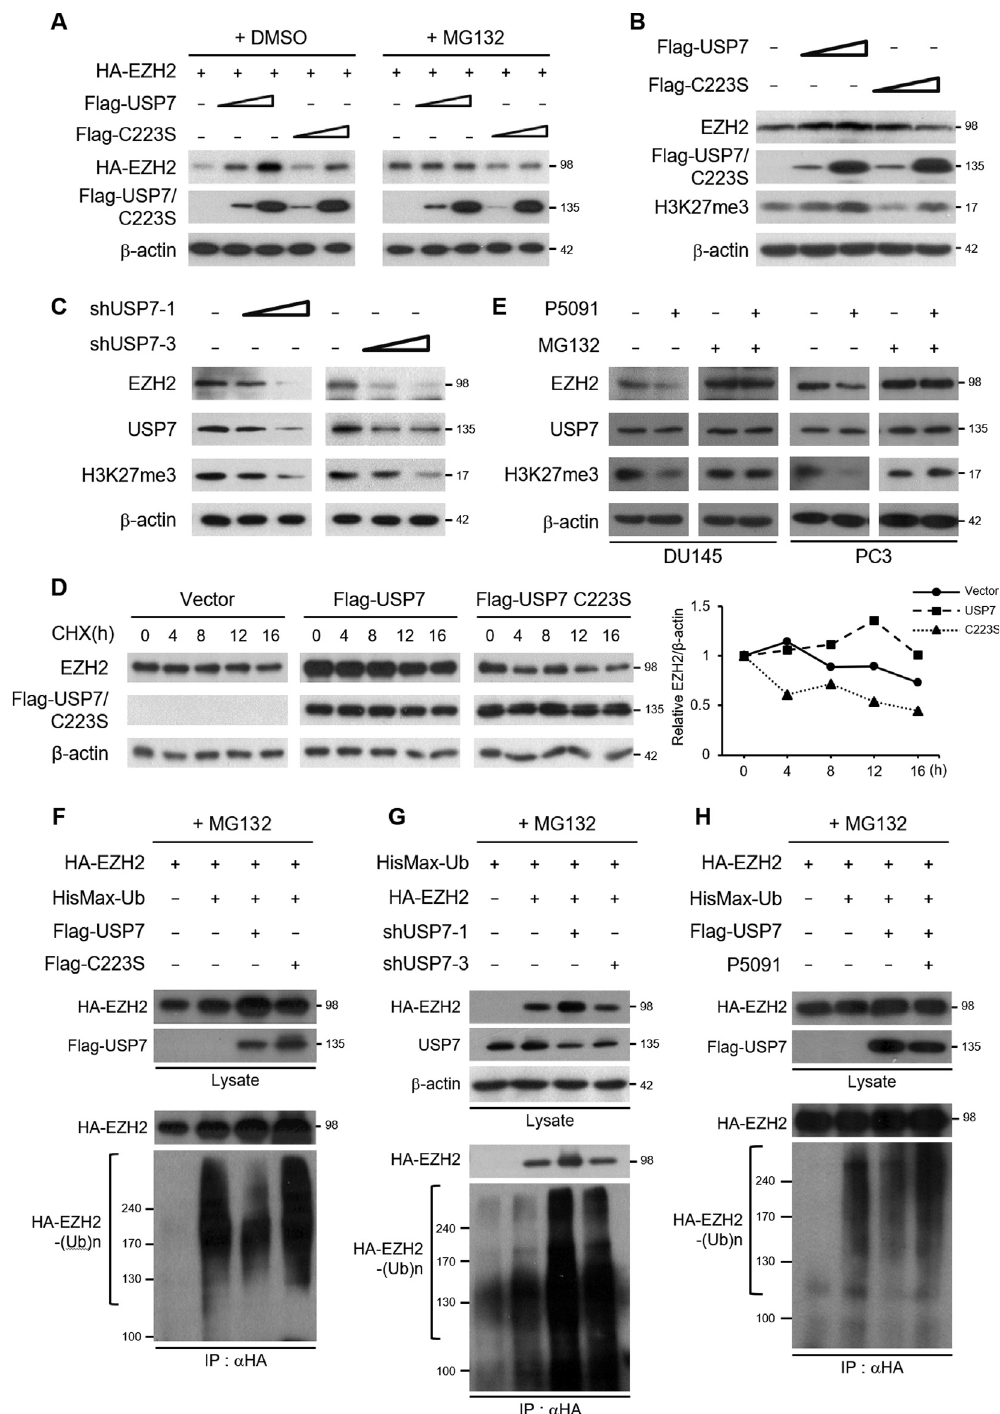
Figure 2 - EZH2 is stabilized through USP7-mediated deubiquitination. (A) HA-EZH2 was expressed in HEK293T cells with Flag-USP7 or Flag-USP7 C223S.CellsweretreatedwithDMSOor10 (cid:2) MMG132for12hbeforeharvesting.Celllysateswereimmunoblottedwithanti-HAoranti-Flagantibody. (B)HEK293TcellsweretransfectedwithincreasingamountsofFlag-USP7orFlag-USP7C223S.CelllysateswereimmunoblottedtodetectFlag-tagged USP7, EZH2, or H3K27me3. (C) HEK293T cells were transfected with increasing amounts of USP7 shRNAs. Cell lysates were immunoblotted to detect EZH2,USP7,orH3K27me3.(D)HEK293Tcellsexpressingemptyvector(control)orFlag-USP7/USP7C223Sweretreatedwithcycloheximide(CHX) fortheindicateddurations.Celllysateswereimmunoblottedwithanti-EZH2oranti-Flagantibody.Thelinegraphrepresentstherelativeproteinlevelsof EZH2normalizedtothoseof (cid:3) -actinusingadensitometerandexpressedasrelativeintensitycomparedtothenon-treatedcontrol.(E)DU145orPC3cells were treated with P5091 (12.5 (cid:2) M) for 24 h and MG132 (10 (cid:2) M) for 12 h. Cell lysates were immunoblotted to detect EZH2, USP7, or H3K27me3. (F), (G), and (H) HEK293T cells were transfected as indicated and treated with MG132 for 12 h before harvesting. Cell lysates were then subjected to immunoprecipitation with HA antibody followed by immunoblotting with anti-HA or anti-Xpress